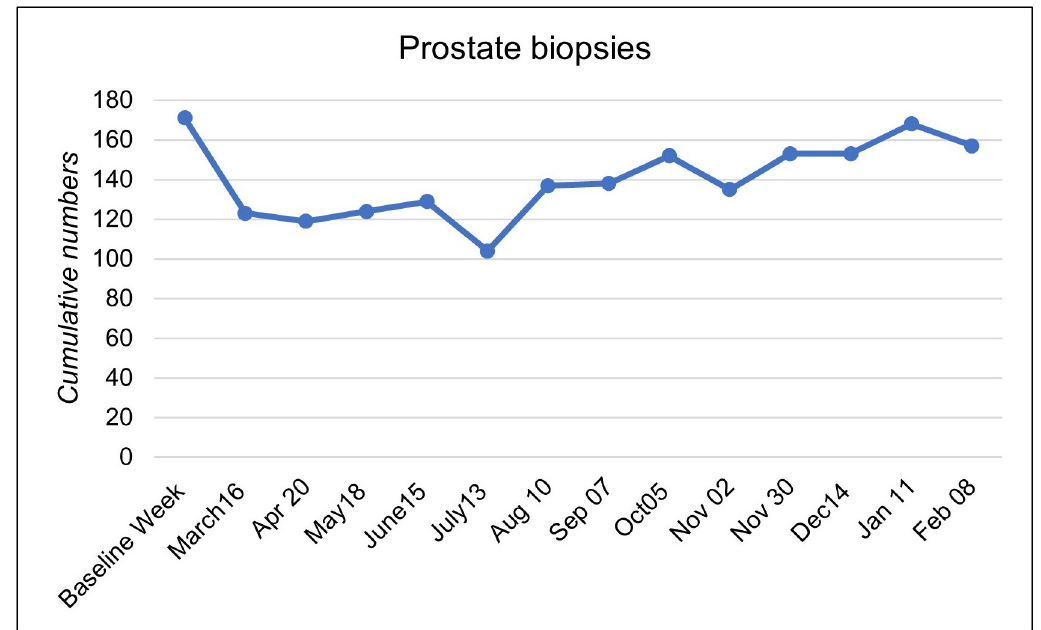
Fig 2. Changes in prostate biopsies. Total numbers of prostate biopsies performed in the baseline week and after the onset of the pandemic.